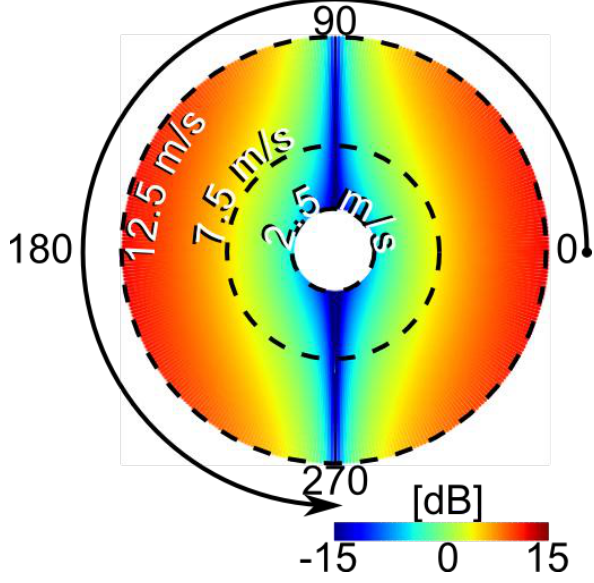
Figure 2. Estimated dampening factor plotted against the relative angle between radar and wind direction. Radial distance from the center indicates the wind speed.